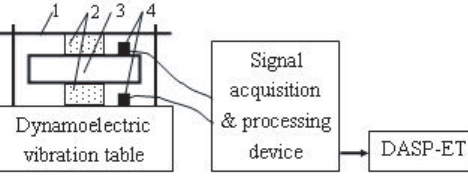
Fig. 3. Test system of vibration transmissibility. 1. Clamp device; 2. Test specimens; 3. Mass block; 4. Acceleration